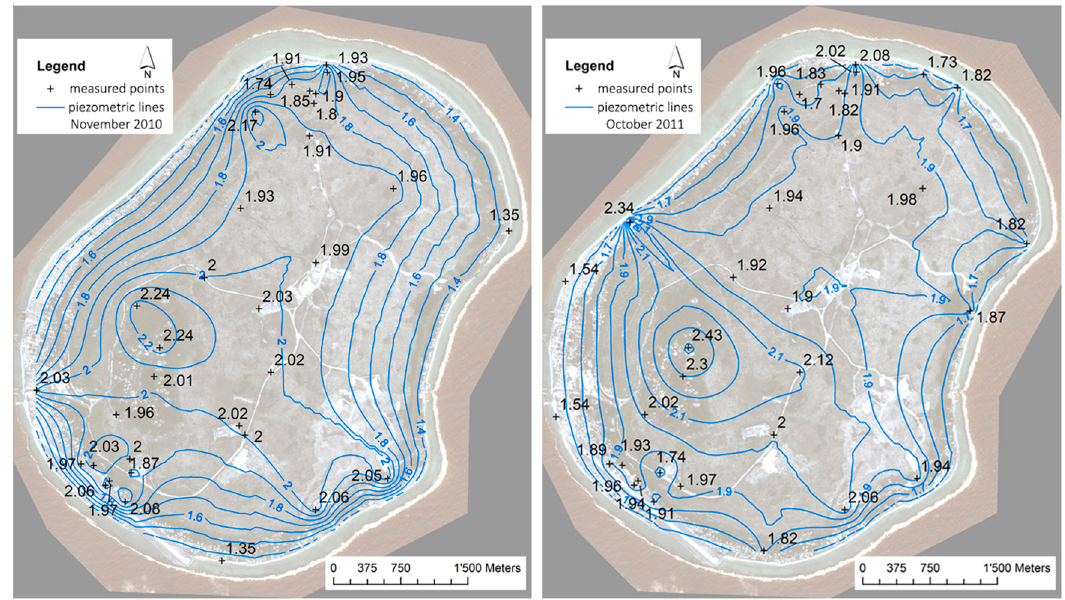
Figure 12. Piezometric maps of the groundwater heads measured in November 2010 and October 2011 (sea level 1.35 and 1.54 m, respectively).